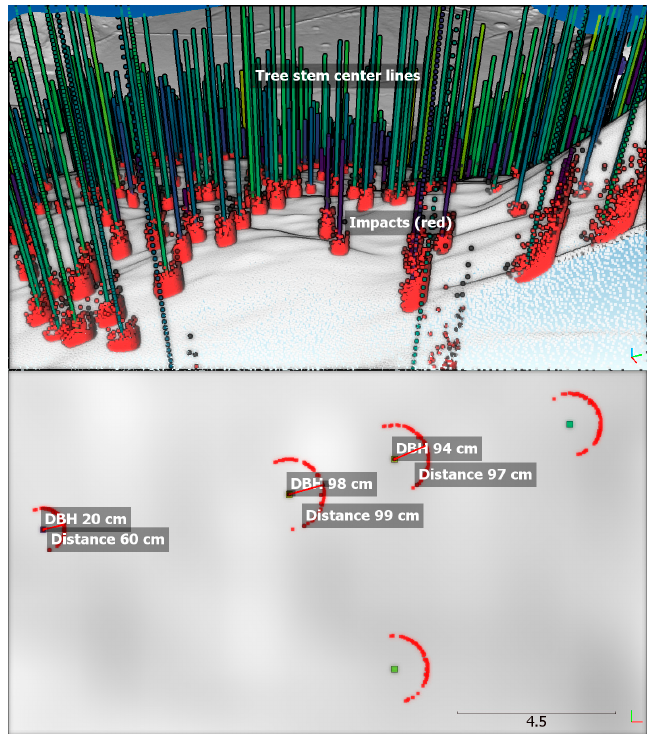
Figure 23. Detected impacts against the tree stems for the simulation with the proposed algorithm seen in 3D and from above. The red points are located at the center of mass of the rock at the im- pact, and their distances from the center of the stems at a height of 1.3 m, thus corresponding to ½ (DBH + d 1 ) based on Equation (1).